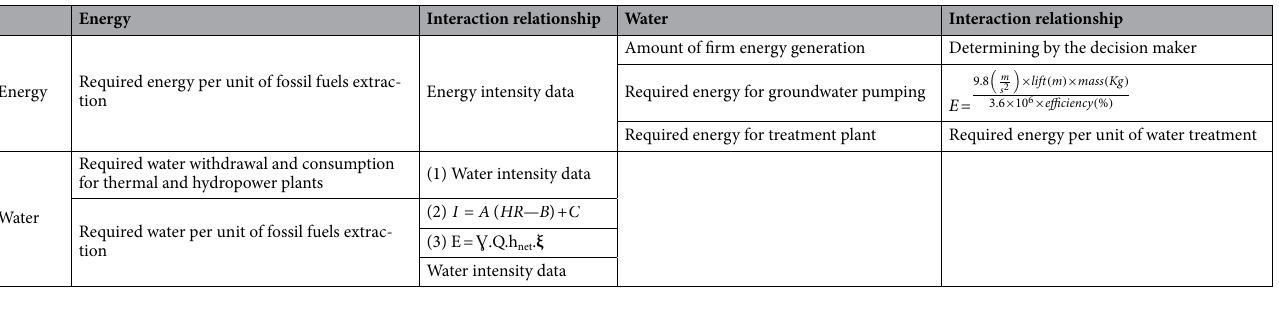
Table 1. Interactions among energy and water on supply side with nexus approach. I, water consumption intensity; A, amount of water required to dissipate one kilojoule of heat based on the type of cooling system; HR, heat rate input to the power plant; B, total heat outputs from the power plant except for the heat flow dissipated by the cooling system; C, required water in other parts of the power plant except the cooling system; E, generated power; Ɣ , specific weight of water; Q, discharge which comes into the turbine; h net , net head of water ; ξ , efficiency of the